Question: Does the plotted quantity increase or decrease?
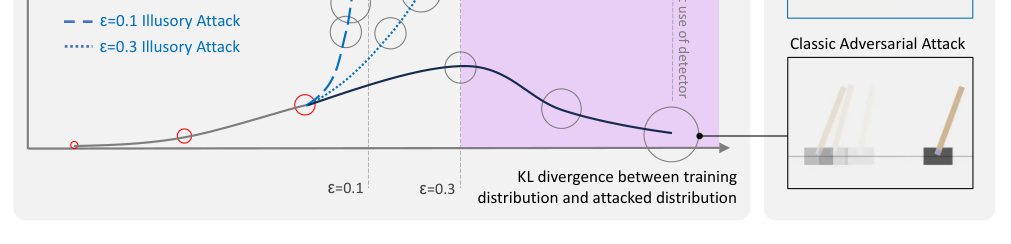
Answer: increasing